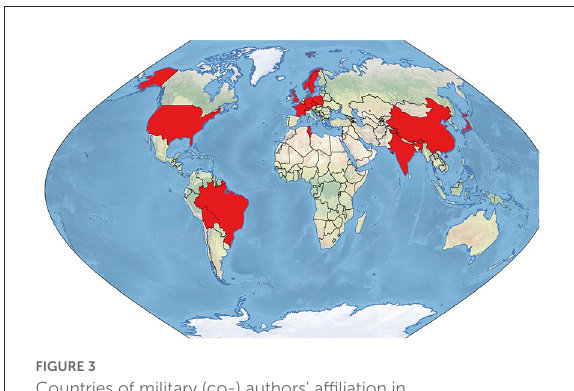
FIGURE4 CIMIC field experiences and analyses during the COVID-19 pandemic. Red: first authors’ countries of affiliation. Yellow: Countries in which CIMIC activities were analyzed by authors from other